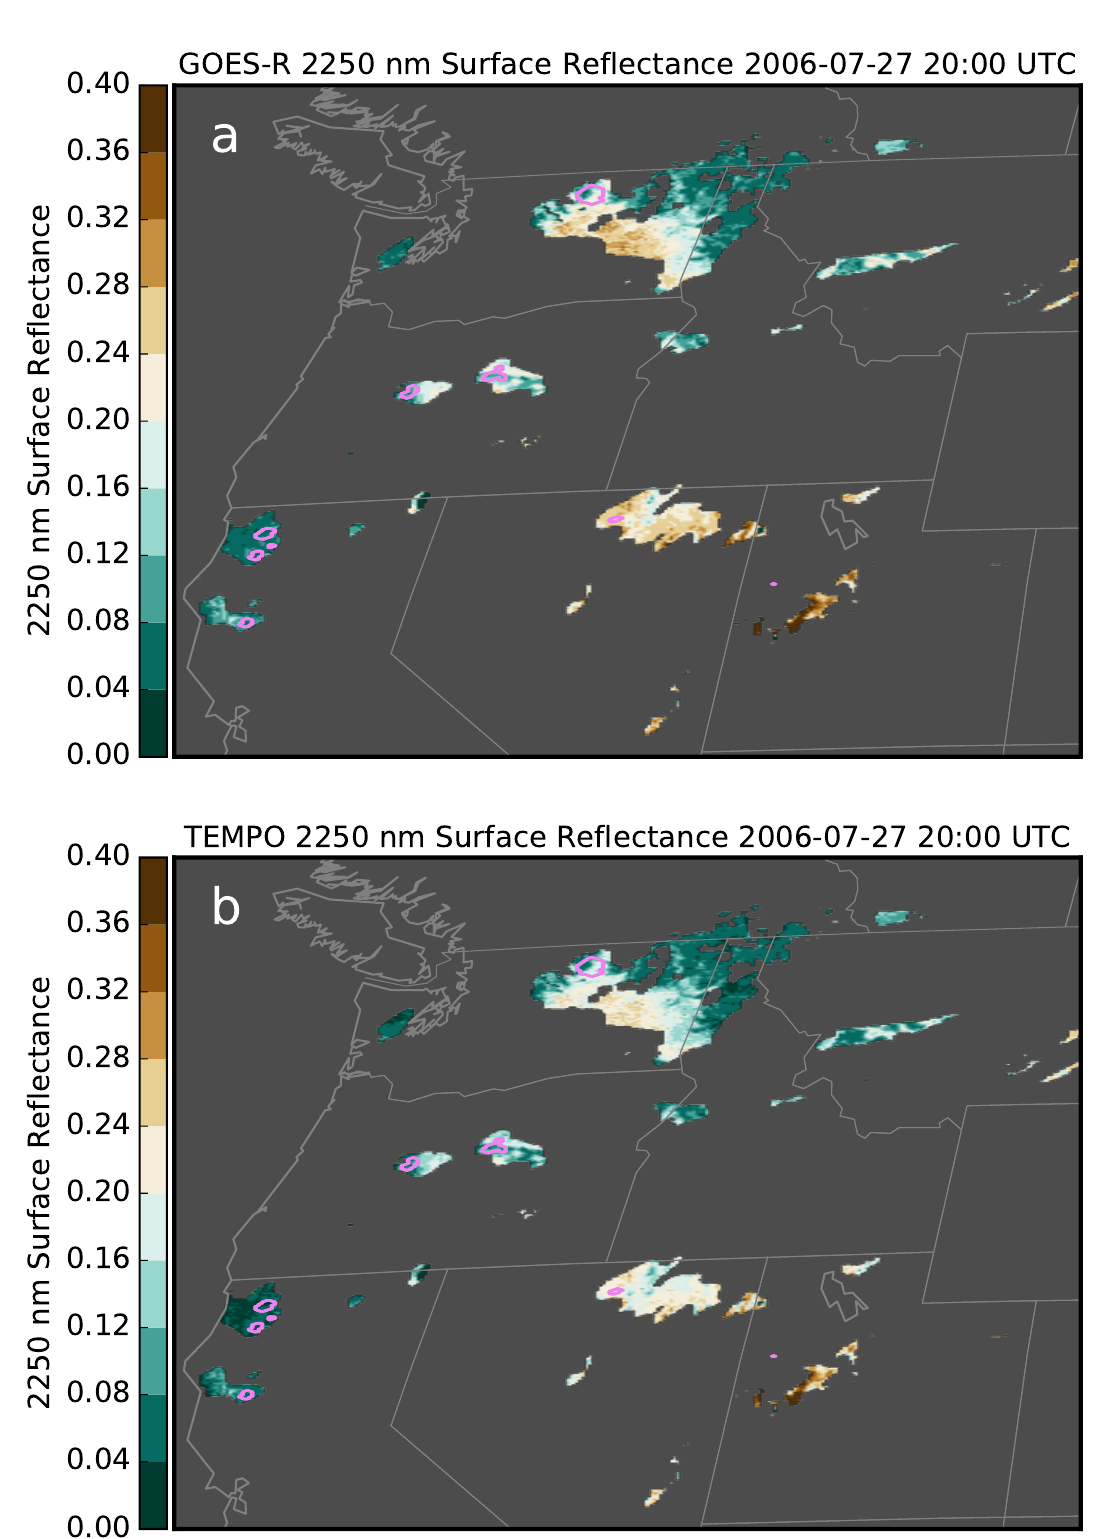
Figure 15. ( a ) Simulated GOES-R 2250 nm surface reflectance re-gridded to the TEMPO resolution, and ( b ) TEMPO 2250 nm surface reflectance for 27 July 2006 at 21 UTC in the G5NR simulation. The purple contours represent the areas that were detected as smoke by the VIIRS aerosol detection